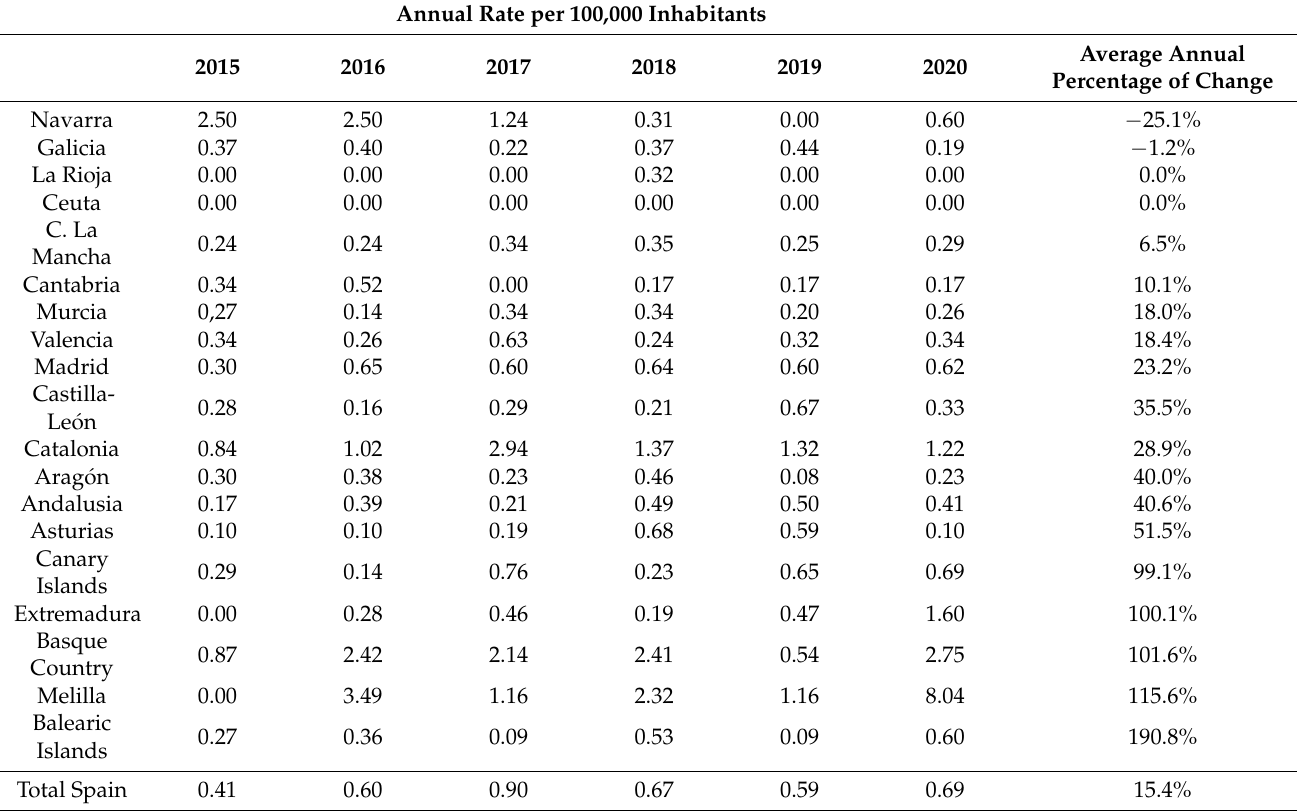
Table 2. Hate crimes based on sexual identity or orientation at the national level and in each autonomous community: annual victimization rates per 100,000 inhabitants and average annual percentage of change. (Ascending